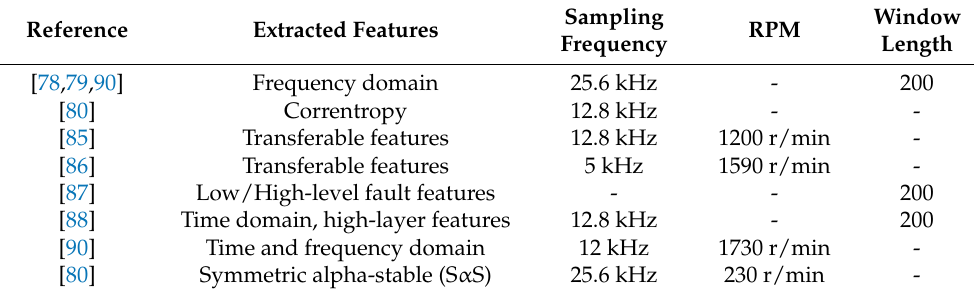
Table 1. Partial extracted features in the